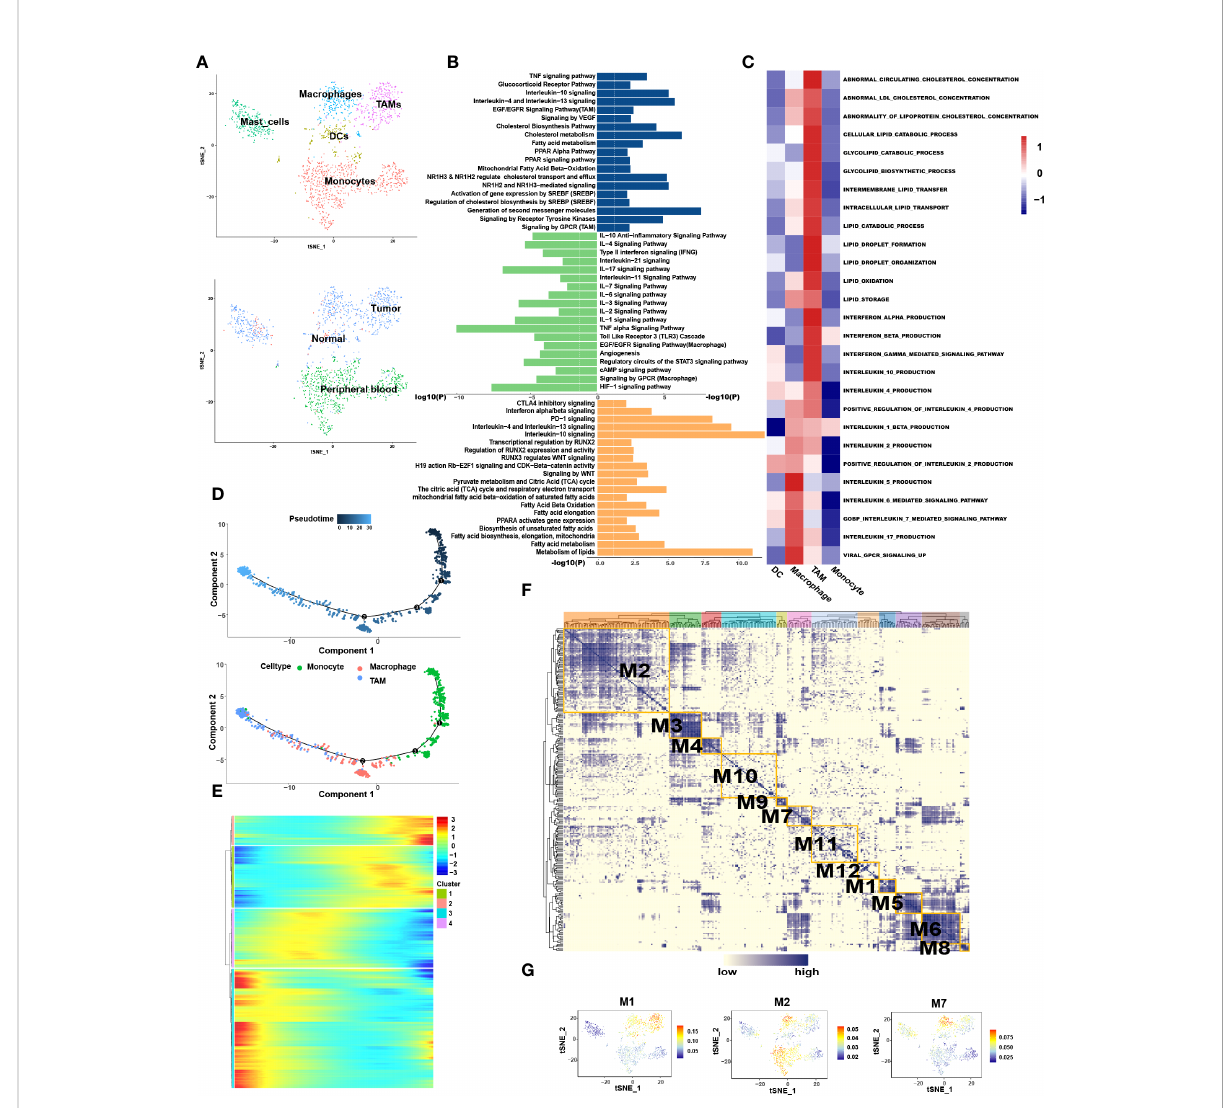
FIGURE 4 Macrophages resulted from M1 polarization, whereas TAMs resulted from M2 polarization in CRC. (A) tSNE plots showing 4 sub-cell types of CD8+ T cells (upper) and their tissue origins (lower). (B) GO and KEGG pathway enrichment analyses of marker genes of TAMs (blue color), Teff (green color) and DCs (orange color). The height of each barplot shows the log10 of P-value calculated using the Metascape database. (C) The heatmap illustrates the activity of biological process and signaling pathway in each cell type by GSVA. (D) Differentiation trajectory of monocytes, macrophages and TAMs in CRC, color-coded for pseudotime (upper) and sub-cell types (lower). (E) Pseudo-heatmap of genes altered in the differentiation process of monocytes, macrophages, and TAMs in CRC, grouped into four clusters. (F) Heatmap of 12 identi fi ed regulon modules based on the regulon CSI matrix. (G) Selected regulon models which upregulated in TAMs (M1) and Macrophages (M2, M7) showed in t-SNE map for myeloid